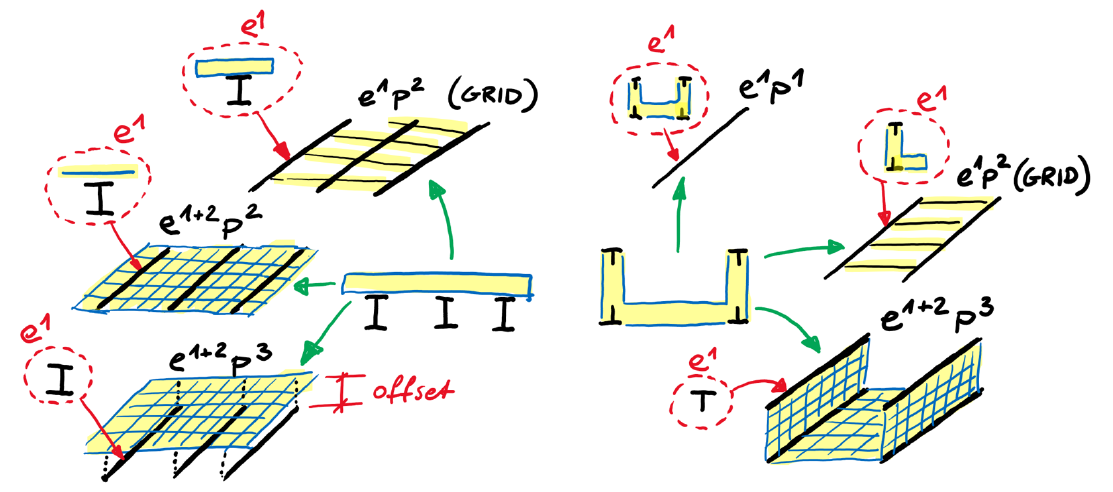
Figure 11: Different numerical models for composite bridges’ analysis (on basis of